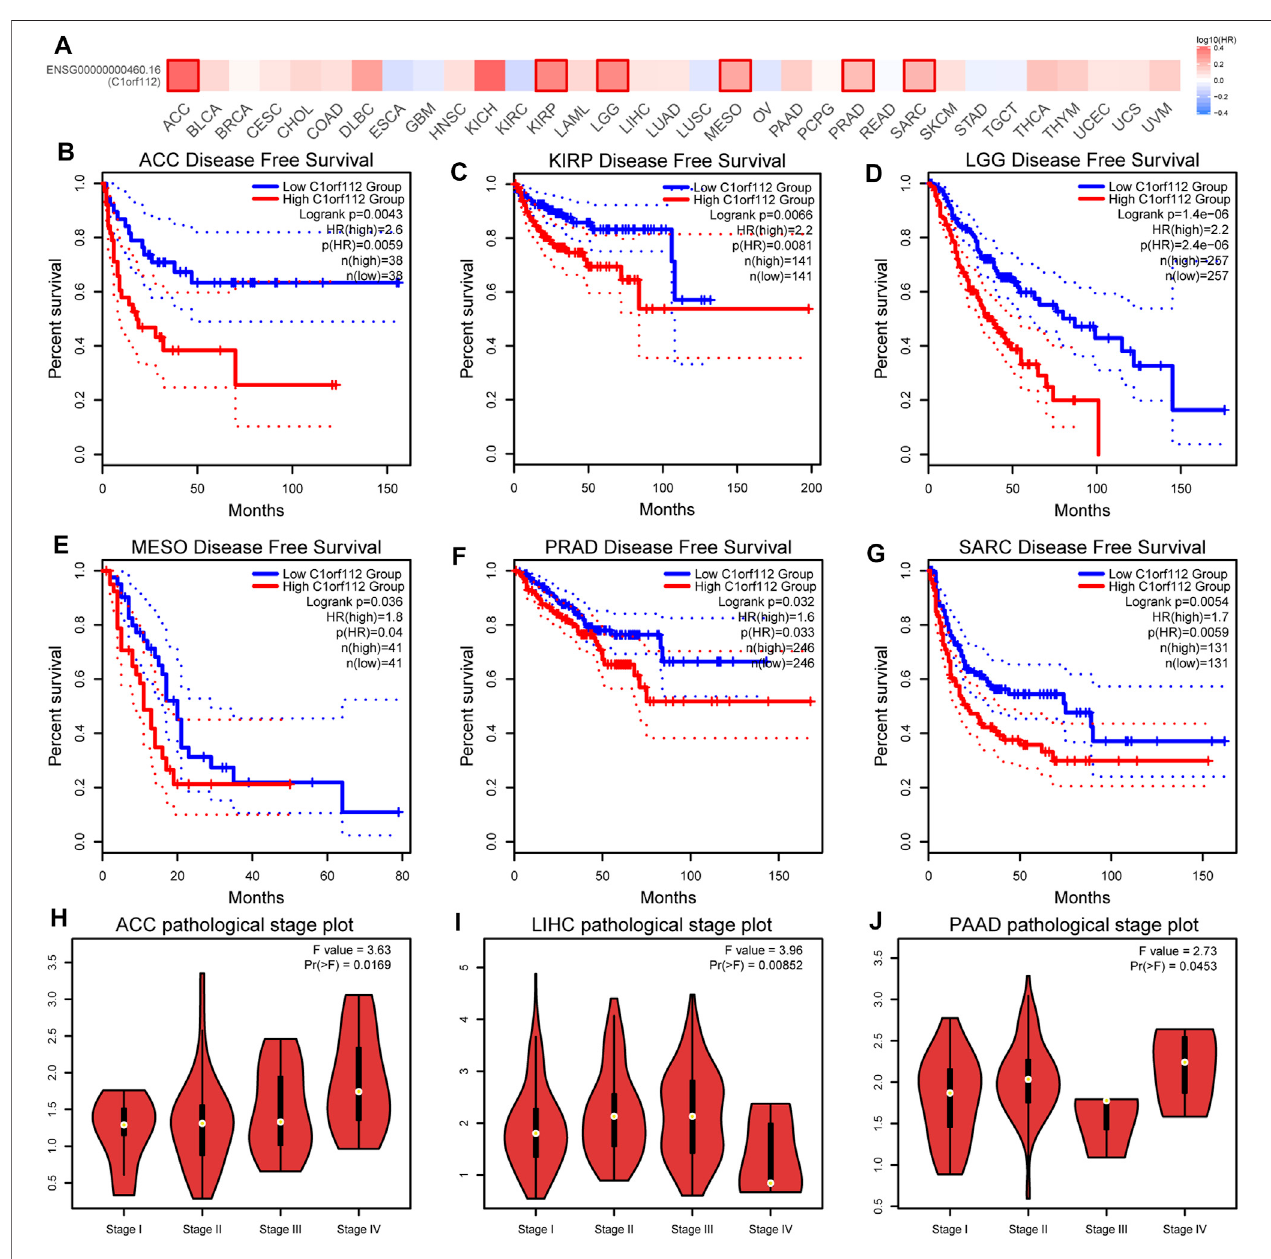
FIGURE3| Correlationbetween C1ORF112 expressionanddisease-freesurvivalinpatientswithdifferentTCGAtumor types.GEPIA2wasusedtobuildasurvival map (A) andconductdisease-freesurvival (B – G) analyses.ThesurvivalmapandKaplan – Meierplotswithsigni fi cantresultsaredisplayed.The95%con fi denceintervals of disease-free survival are indicated by red and blue dotted lines for high and low C1ORF112 groups, respectively. (H – J) Correlation between C1ORF112 expression and pathological stages of ACC, LIHC, and PAAD from TCGA datasets. Log2 (TPM + 1) was applied for log-scale.